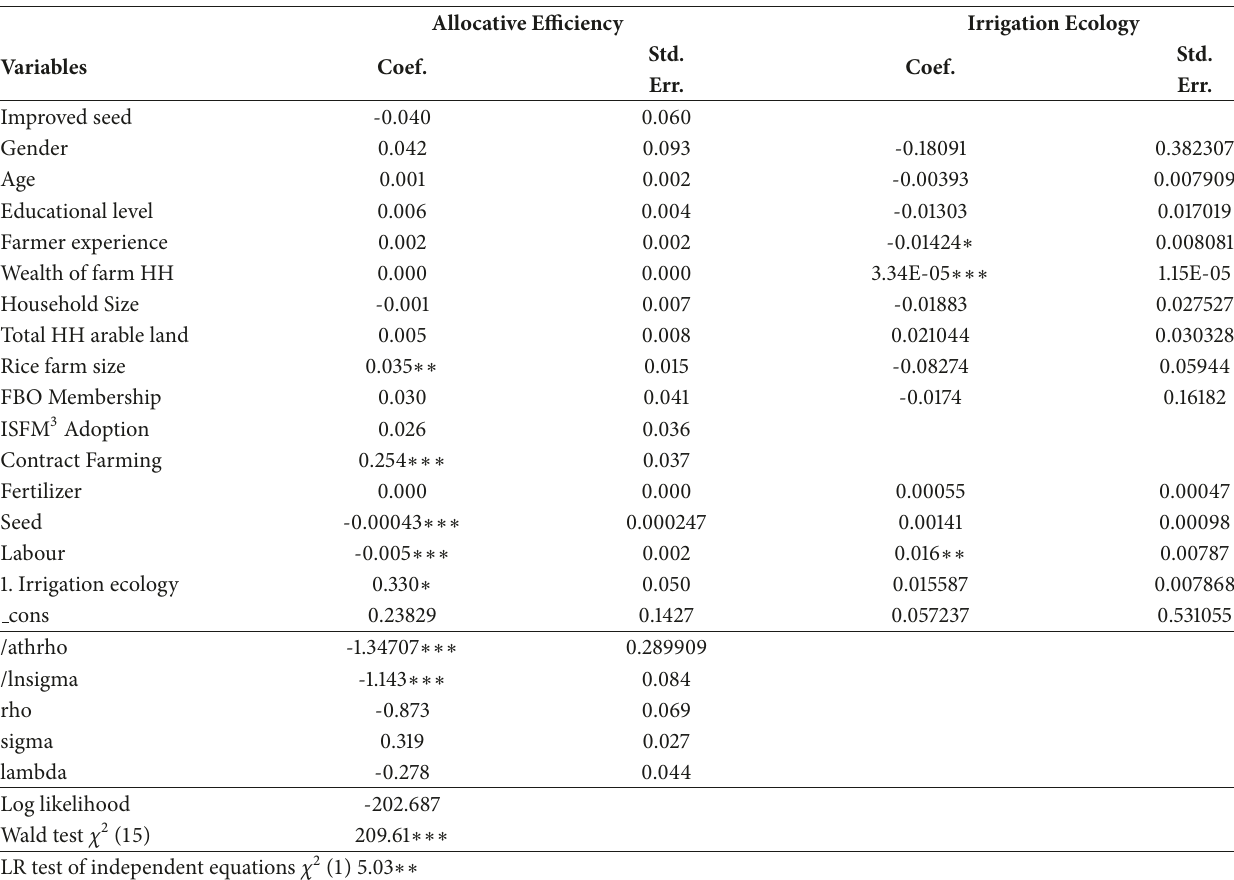
Table 8: Estimates of the endogenous treatment effect model of impact of irrigation ecology on allocative